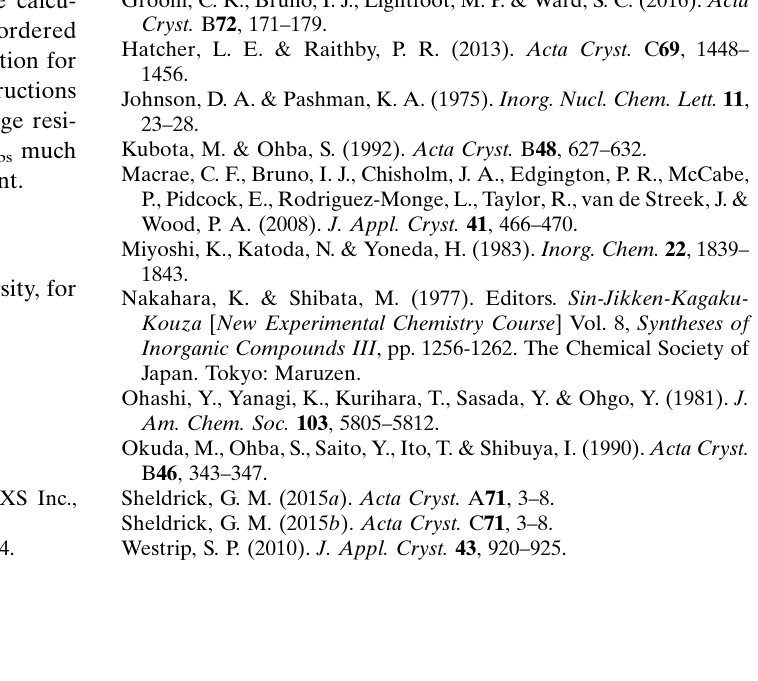
Crystal data Chemical